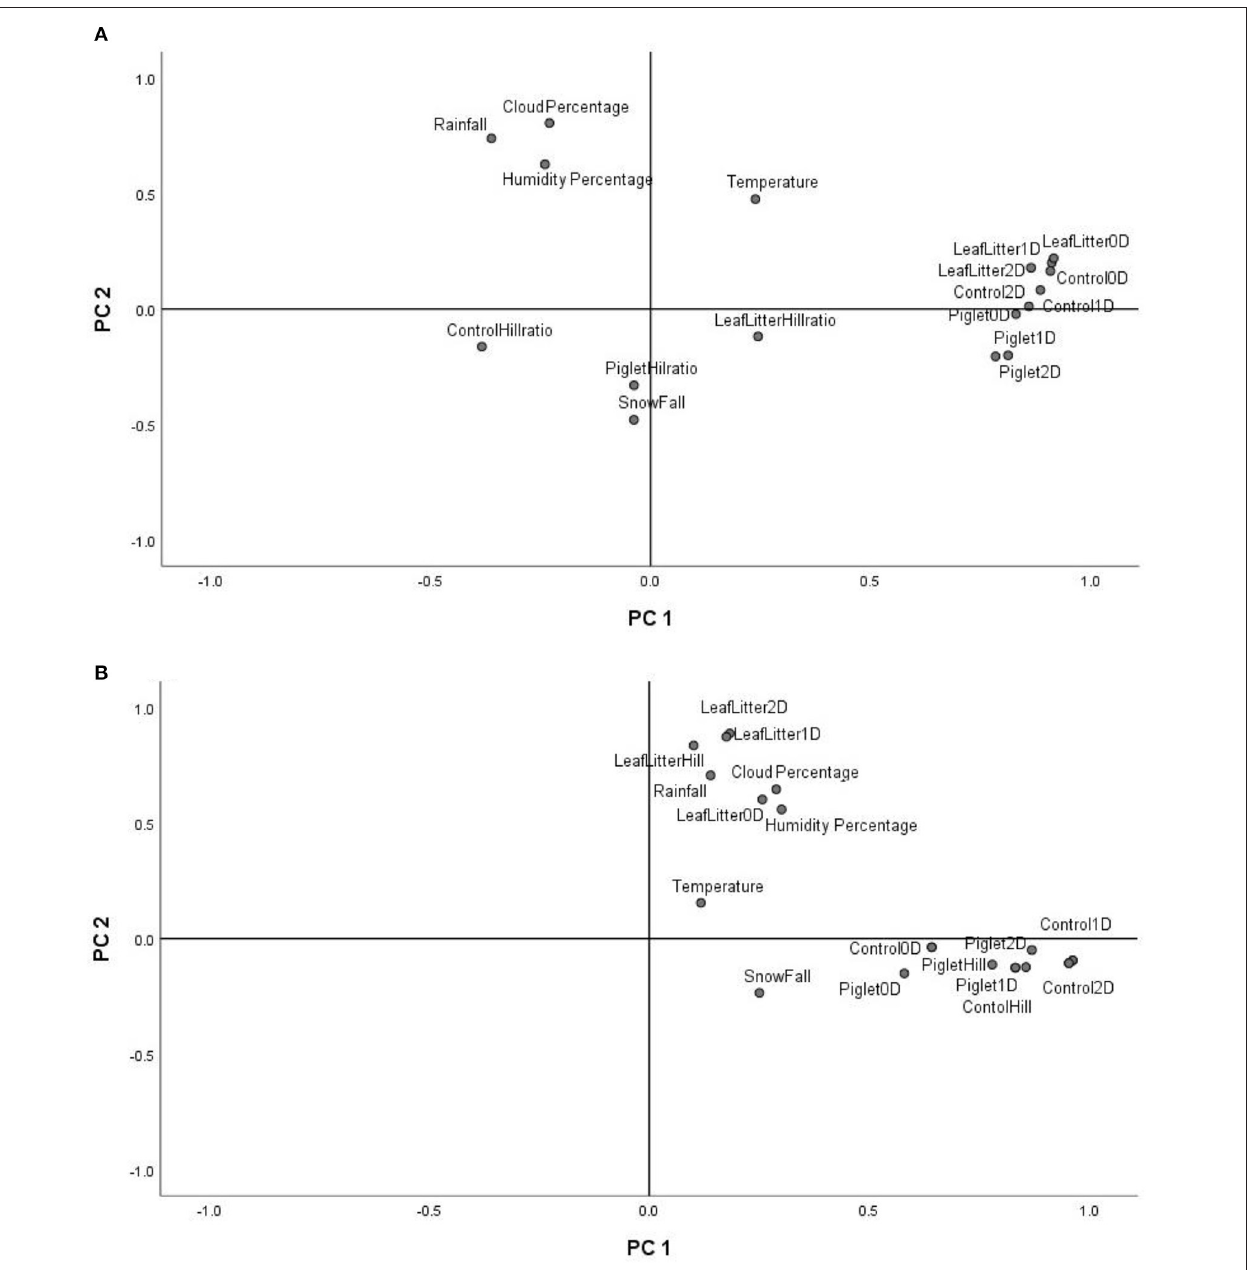
FIGURE 4 | PCA biplot of18S fungal (A) and 16S bacterial community (B) ecological indices (Hill number 0 D, 1 D, 2 D and Hill ratio 1 D/ 0 D) of the control, leaf litter and piglet soils.